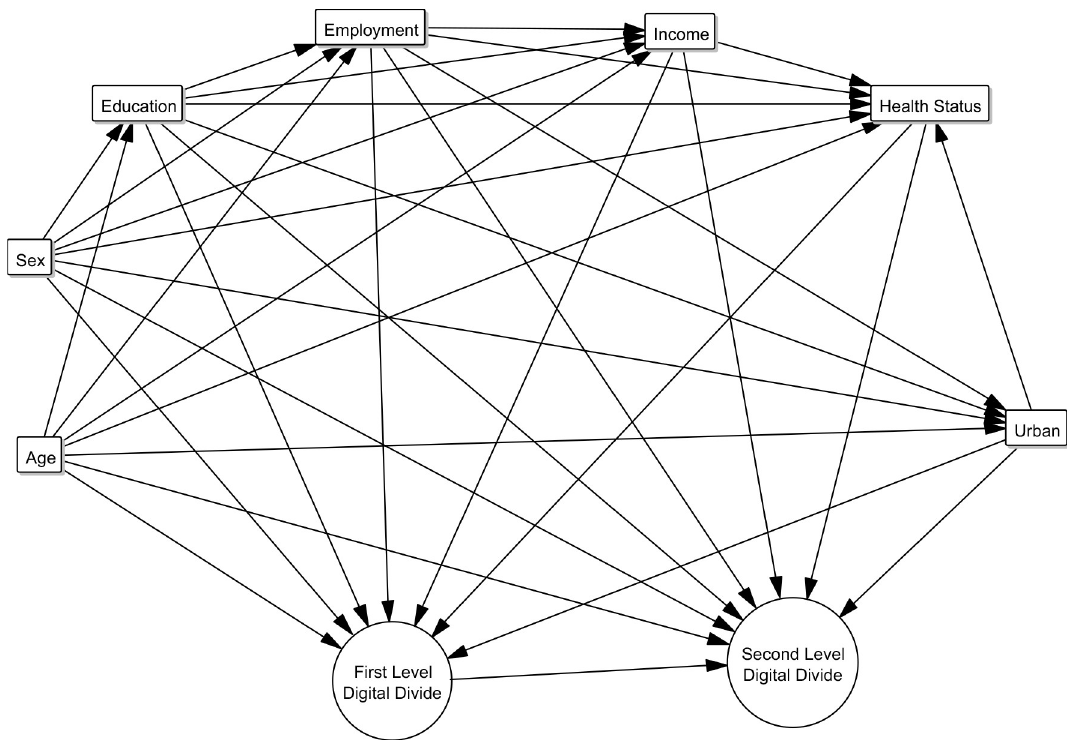
Fig 1. A directed acyclic graph portraying the different causal pathways which influence internet access and digital skills development.